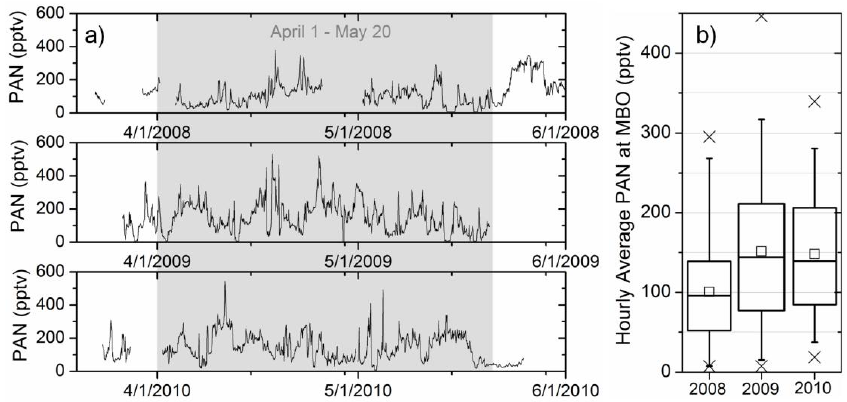
Figure 1: (a) Hourly average PAN mixing ratios at Mount Bachelor for three spring seasons. (b) Box and whisker plots of the hourly average